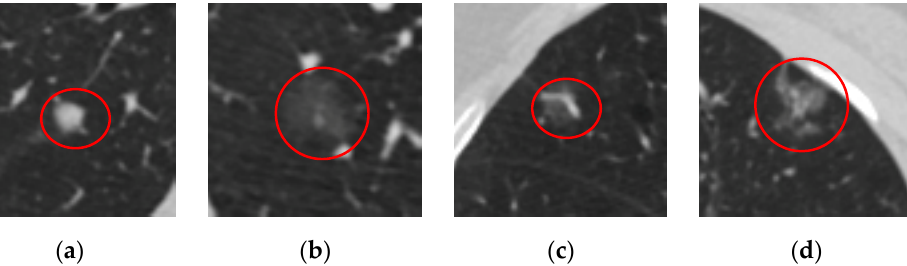
Figure 1. Examples of the four pathological subtypes of GGNs. ( a ) Benign; ( b ) AIS; ( c ) MIA; ( d ) IA. Table 1. The GGNs subtypes of 146 patients. Pathological Subtypes